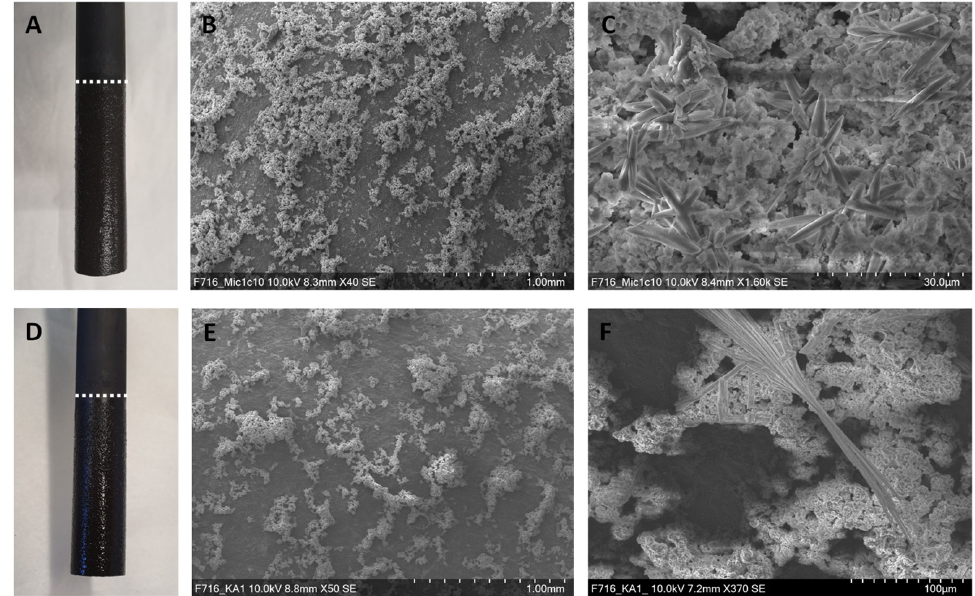
Figure 3. Photographs of the cathodes after electromethanogenesis with ( A ) M. maripaludis Mic1c10 and ( D ) M. maripaludis KA1. SEM pictures of cathodes used in electromethanogenesis with strain Mic1c10 ( B , C ) and strain KA1 ( E , F ).